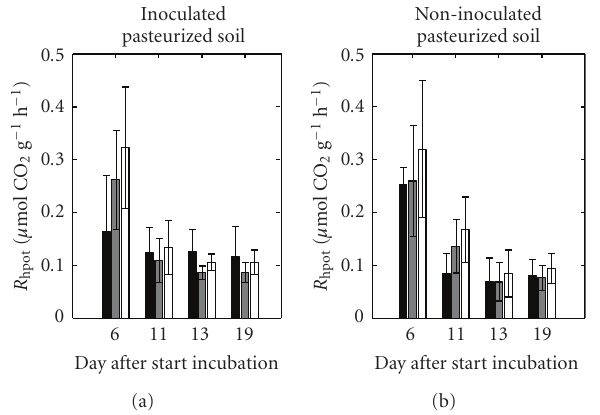
Figure 2: Mean potential heterotrophic respiration ( R hpot ) mea- sured at 20 ◦ C for the inoculated and non-inoculated pasteurized soil under ambient conditions (black bars) and under combined warming and CO 2 enrichment (grey bars). For the future climate scenario, we also computed Rhpot at 23 ◦ C (white bars), using (1) with b = 23 ◦ C and Q 10 = 2, such that we could compare Rhpot at growth conditions (for more details, see Section 2). Error bars represent the standard deviation on the mean.